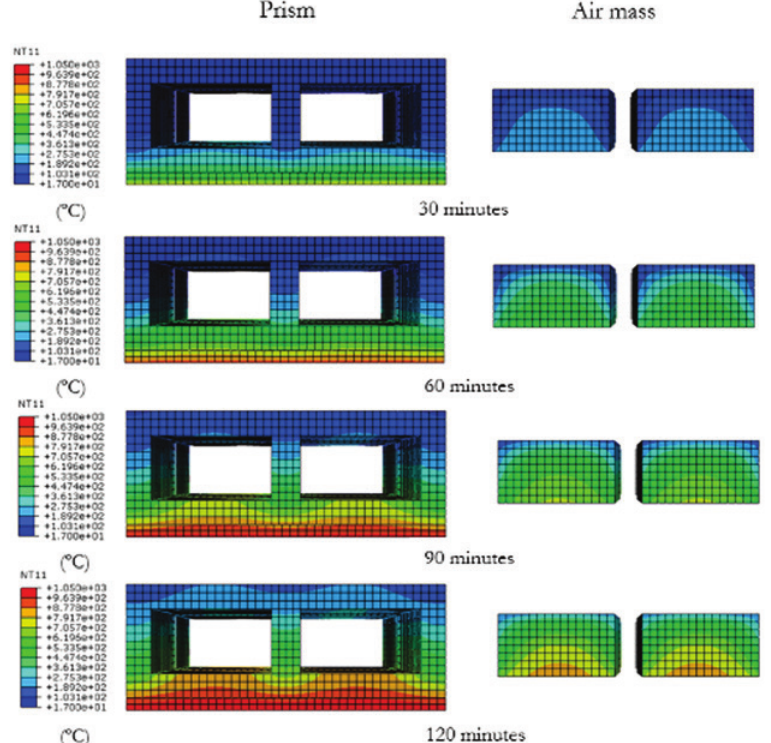
Thermal fields developed in the coated prism on one face and in air